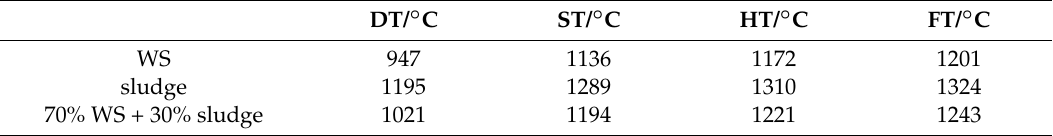
Table 1. Melting characteristic temperature of the fuel ashes produced at 800 ◦ C. DT: deformation temperature; ST: softening temperature; HT: hemispherical temperature; FT: flowing temperature. DT/ ◦ C ST/ ◦ C HT/ ◦ C FT/ ◦ C WS 947 1136 1172 1201 sludge 1195 1289 1310 1324 70% WS + 30% sludge 1021 1194 1221